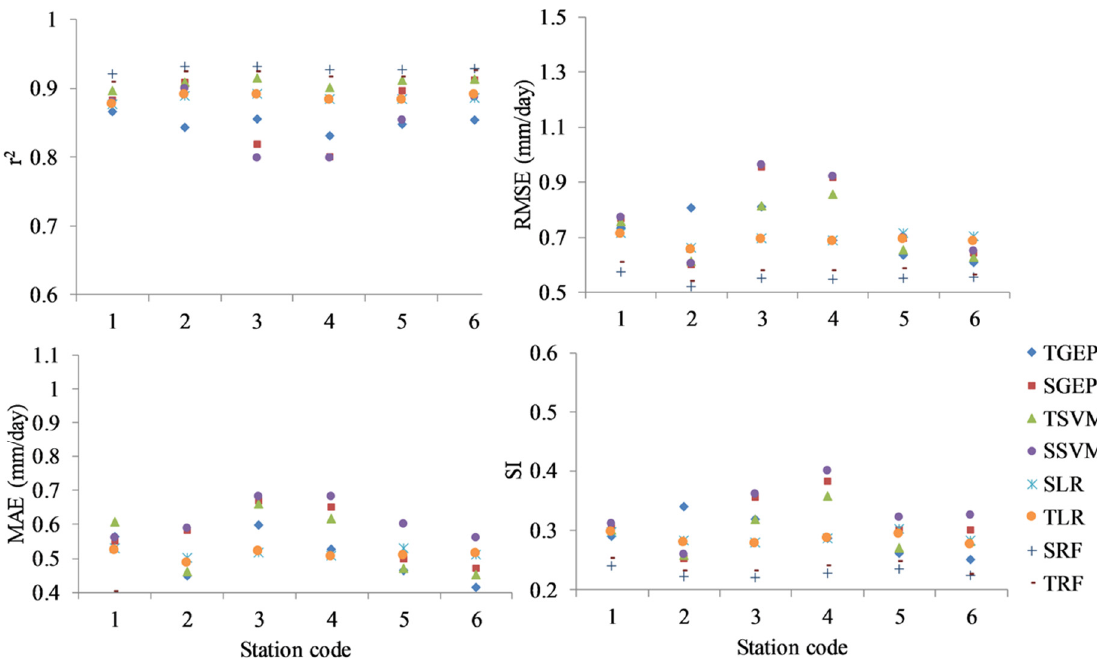
Figure 3. Statistical indices of radiation-based combination for the four applied models (GEP, SVM, LR, and RF) with local (T) and spatial (S) approaches.